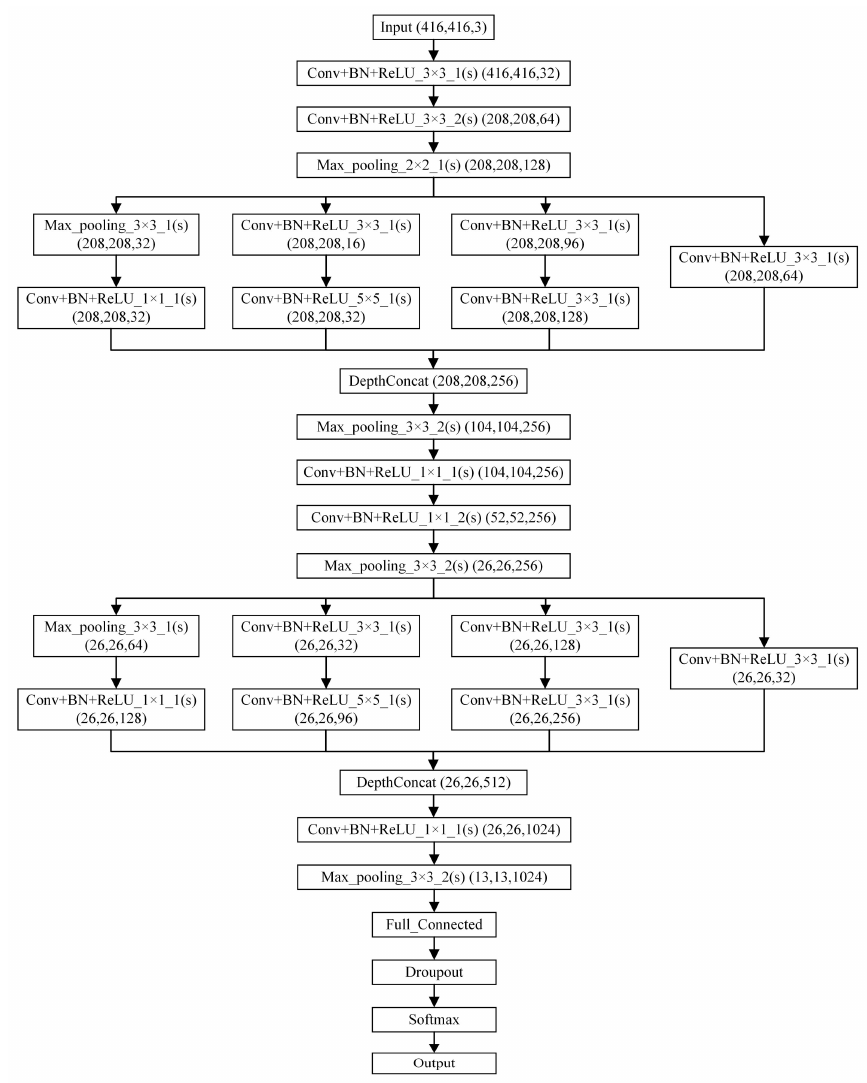
Figure 2. Lesion classification model